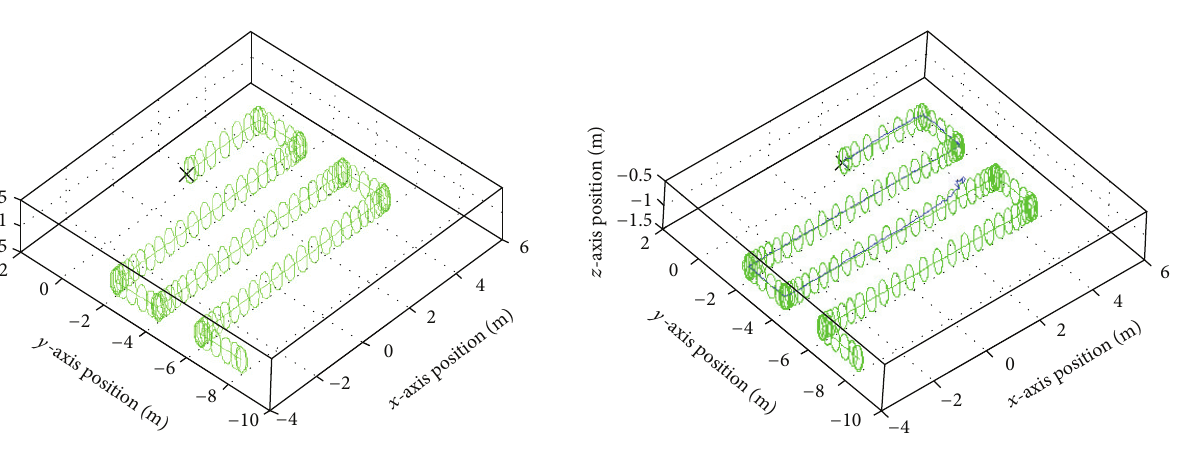
Figure 2: The desired lawnmower trajectory where “ × ” marks the initial position of the AUV.